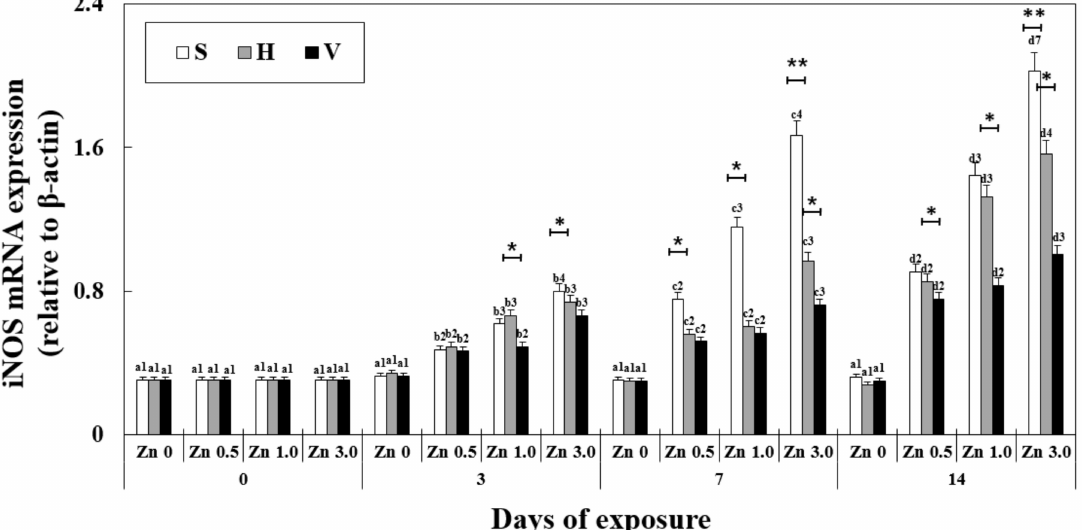
Figure 3. Changes in the mRNA expression of iNOS measured for 14 days. Different letters indicate significant differences among goldfish exposed to the same Zn concentration and water hardness for different exposure times ( p < 0.05). Different numbers indicate significant differences among goldfish exposed to different Zn concentrations at the same water hardness level and for the same duration. The symbol “*” and “**” represent statistical significance ( p < 0.05 and p < 0.01, respectively) among goldfish exposed to different water hardness levels at the same Zn concentration and for the same duration. Values are mean ± SD ( n =